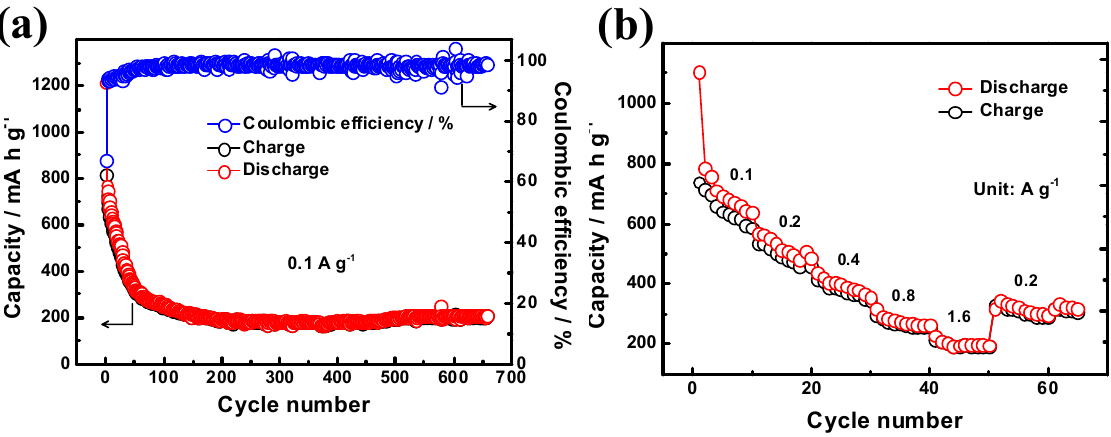
Figure 6. ( a ) Cycling performance of the Cu 16.2 Sn 23.8 at current density of 0.1 A g − 1 . ( b ) Rate performance at various current densities from 0. 1 A g − 1 to 1.6 A g − 1 .